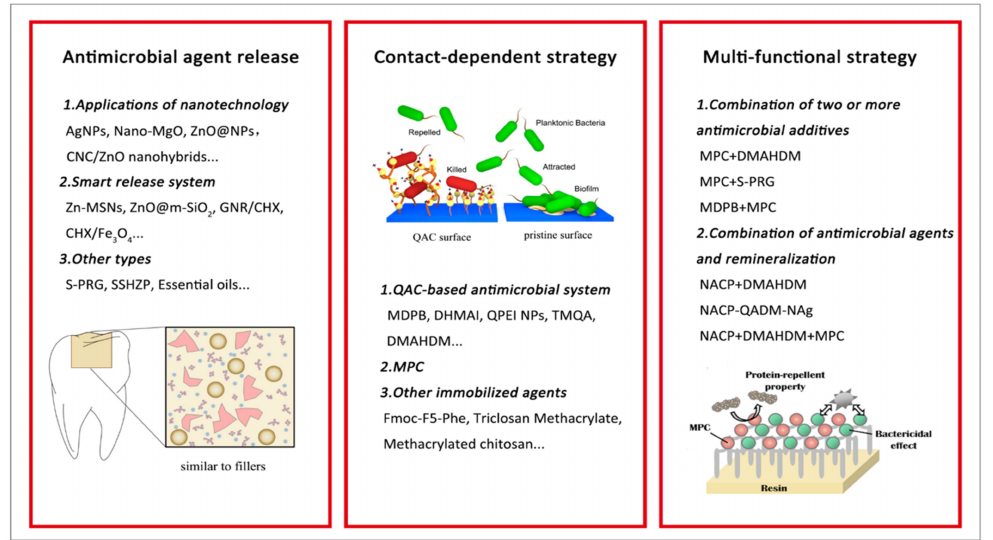
Figure 1. Examples of strategies for material composition modifications toward the design of antibiofilm resin-based composites. AgNPs: silver nanoparticles; MgO: magnesium oxide; CNC/ZnO: cellulose nanocrystal/zinc oxide;